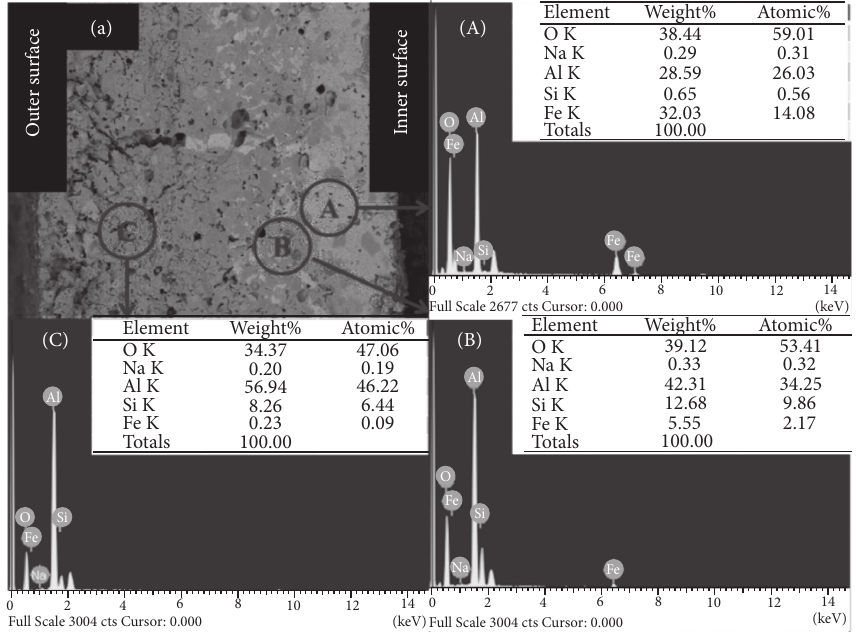
Figure 1: The schematic diagram of the algorithm model.